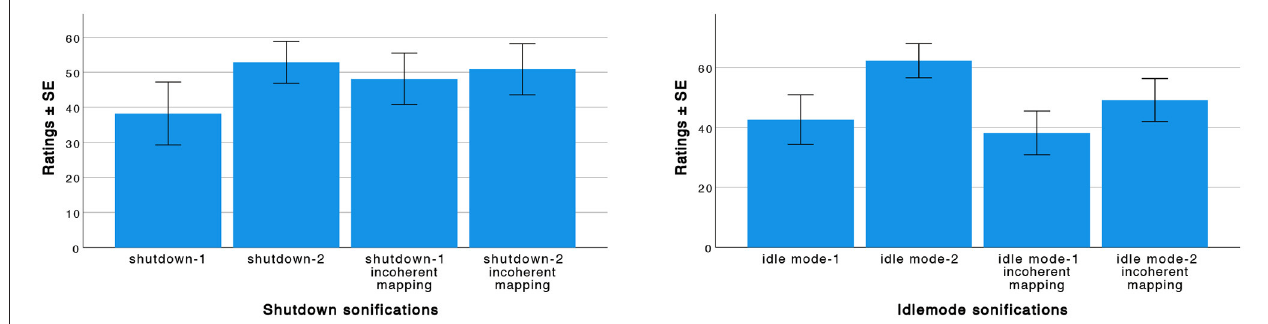
FIGURE 7 | Pleasantness: mean ratings and SE for the eight sonifications. “1” stands for the first aesthetic (glitch sound model) and “2” stands for the second aesthetic (Paetzold recorder sound